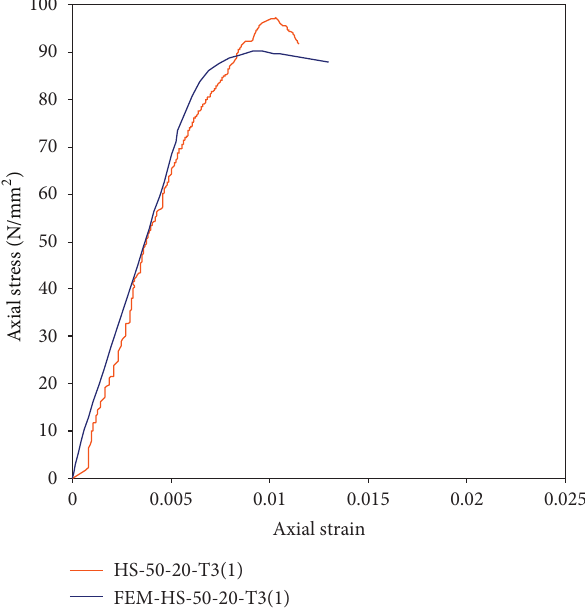
Figure 32: Comparison of experimental and computed axial stress-strain behaviours of HS-50-20-T3 (1)